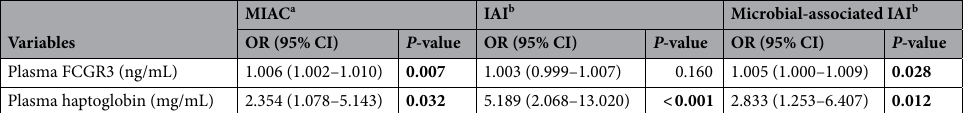
Interactions between plasma FCGR3A, haptoglobin, and LRP1 levels were not found for the presence of MIAC, IAI, and microbial-associated IAI (Table S8). The AUC values of plasma FCGR3A and haptoglobin for predicting MIAC were 0.65 and 0.59, and for IAI were of 0.60 and 0.63, respectively (Table 4 and Fig. 3A,B). Similarly, for the prediction of microbial-associated IAI, the AUC values of plasma FCGR3A and haptoglobin were of 0.64 and 0.62, respectively (Table 4 and Fig. 3C). Differences in the AUC values between plasma FCGR3A and haptoglobin were not statistically significant for predicting any of the three outcome measures ( P = 0.370–0.758). Moreover, the AUC values of plasma FCGR3A and haptoglobin were similar to those of serum CRP with respect to each of the corresponding outcome meas- ures ( P = 0.299–0.879). Repetition of the univariate and multivariate analyses after excluding data that had been included in the discovery study ( n = 164), the results for each outcome measure were confirmed, being the same as those observed in the total cohort ( n = 182) (Tables S5, S6, and S7). No correlations were found among the measured plasma proteins (FCGR3A, haptoglobin, and LRP1) (all variables, r = − 0.078 to 0.051, P > 0.2). In the multi-marker panel for the diagnosis of MIAC, plasma FCGR3 and serum CRP levels were identified as the best combination (Table S9), with an AUC value of 0.68 (95% confidence interval [CI]: 0.59–0.76; P = 0.380 by Hosmer–Lemeshow test), which was not significantly higher than those for plasma FCGR3 and serum CRP ( P = 0.373 and 0.107, respectively) (Table 4). Similarly, for predicting microbial-associated IAI, plasma FCGR3 levels along with serum CRP levels were identified as the best combination (Table S9), with an AUC value of 0.69 (95% CI: 0.61–0.78; P = 0.184 by Hosmer–Lemeshow test). The AUC value for this two-biomarker panel was similar to those of plasma FCGR3 and serum CRP ( P = 0.141 and 0.156, respectively) (Table 4). However, in the IAI predictive model, plasma FCGR3A, plasma haptoglobin, and serum CRP levels were set in the logistic regression model as predictors, but only serum CRP level was selected for the best multi-marker panel; thus, a predictive model for IAI could not be generated.